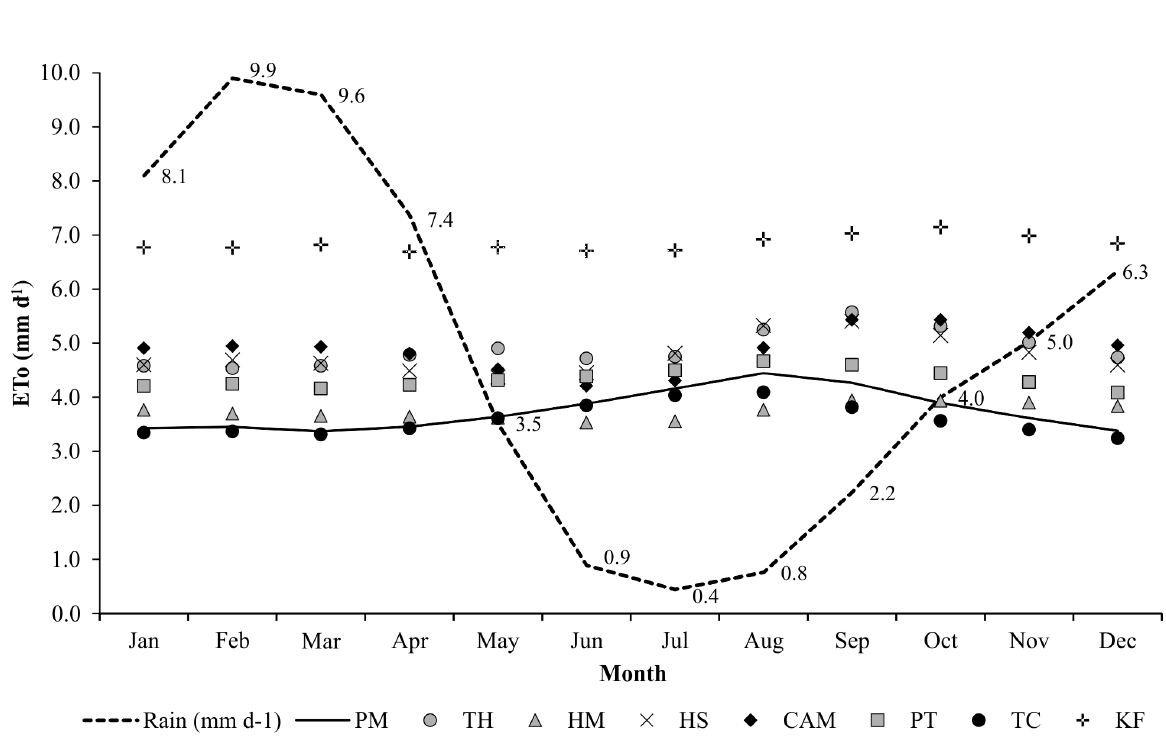
Figure 2 - Comparison between the behavior of rainfall and ETo, expressed in mm.d -1 , obtained via eight empirical methods for the IRW throughout the year for 1980–2013. Rain = Rainfall; PM = Penman-Monteith; TH = Tornthwaite; HM = Hamon; HS = Hargreaves-Samani; CAM = Camargo; PT = Priestley-Taylor; TC = Turc; KF =